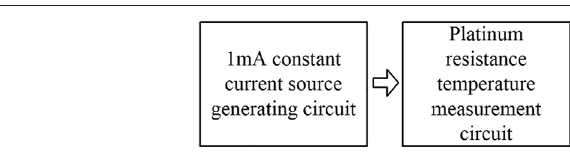
FIGURE 3 | Block diagram of the temperature measurement principle.